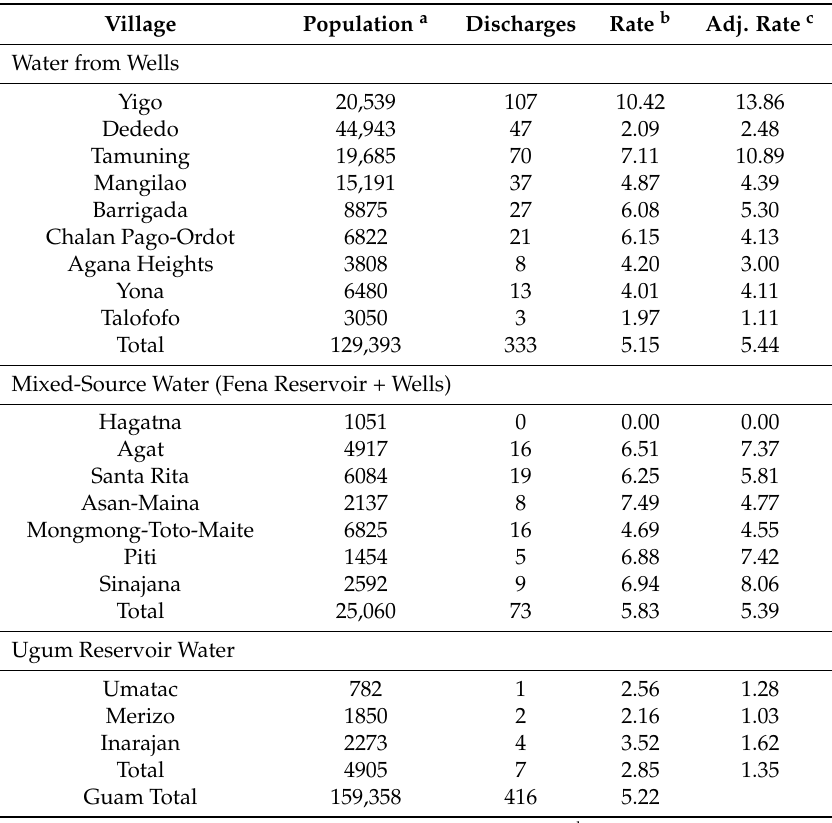
Table 3. Incidence of first-mentioned discharge for urolithiasis by village of residence, Guam Memorial Hospital,